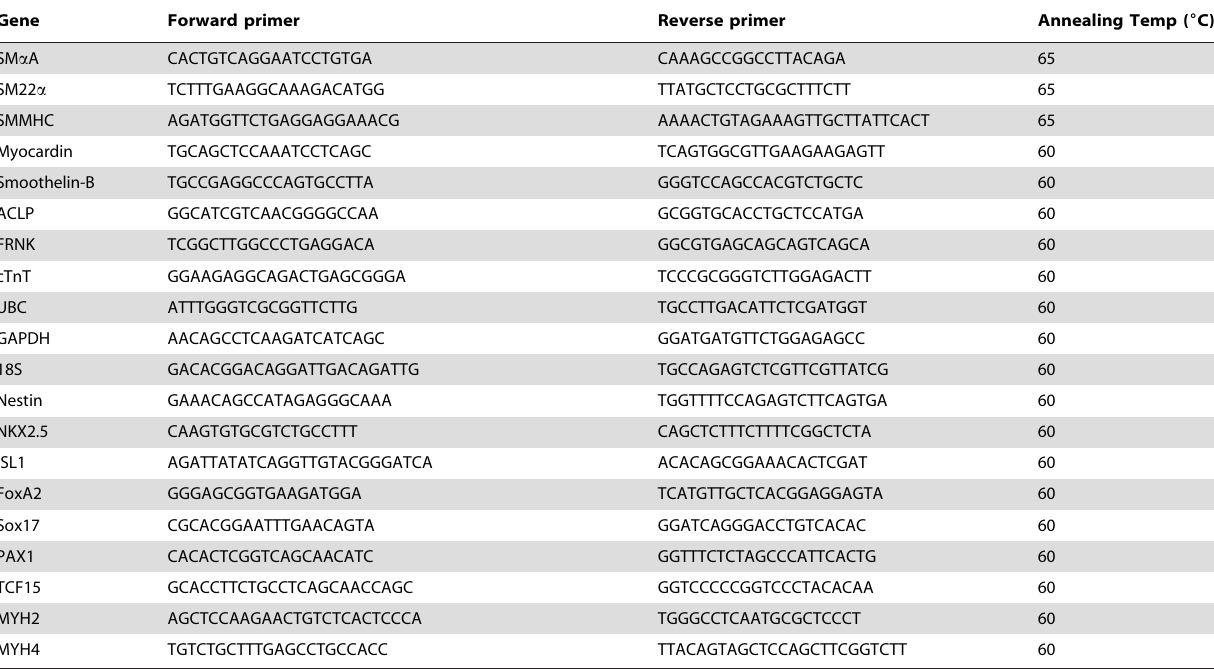
Table 1. Primer sequences used for real time